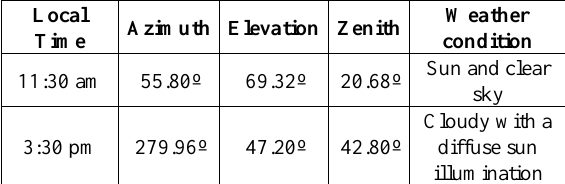
Table 2. Information about the weather and solar angles of acquisition.